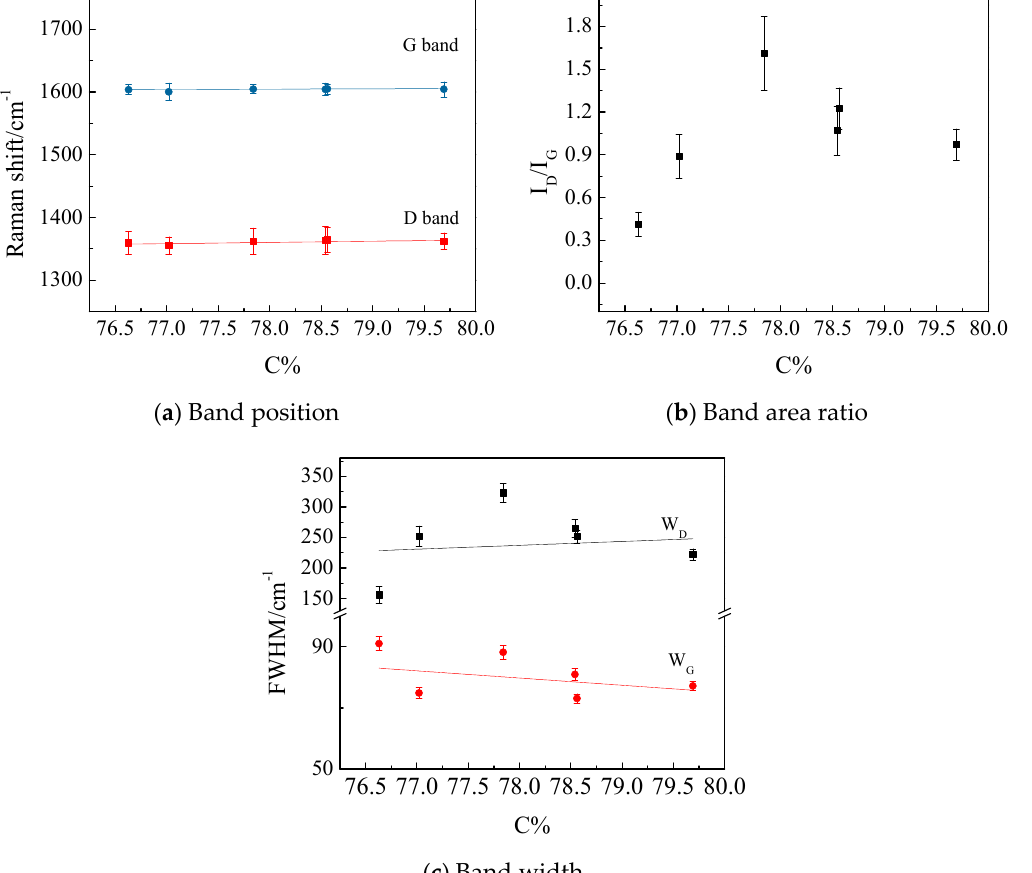
Figure 5. Effect of coal rank on ( a ) the band position (P G and P D ), ( b ) area ratio (I D /I G ), and ( c ) width of the coal samples.